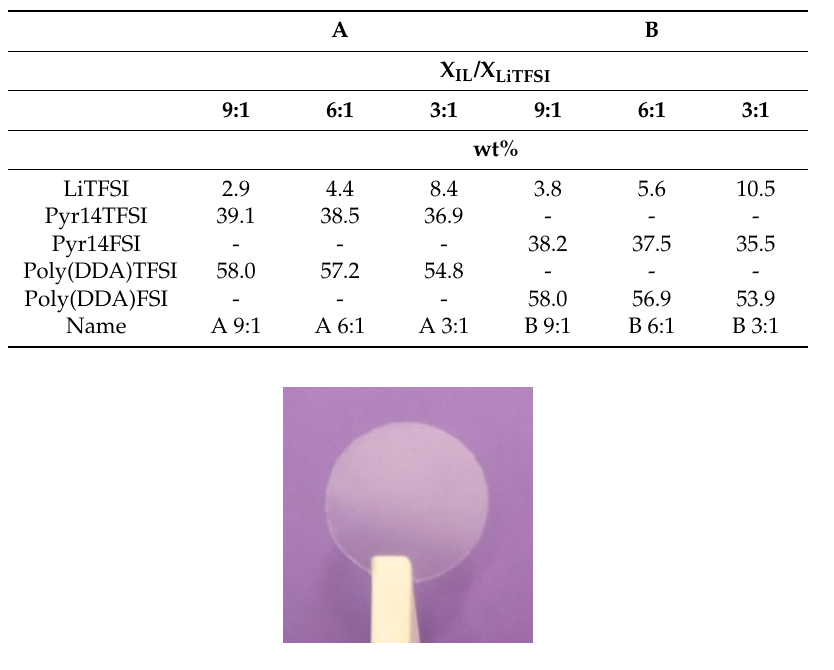
Table 2. Compositions of the electrolytes.